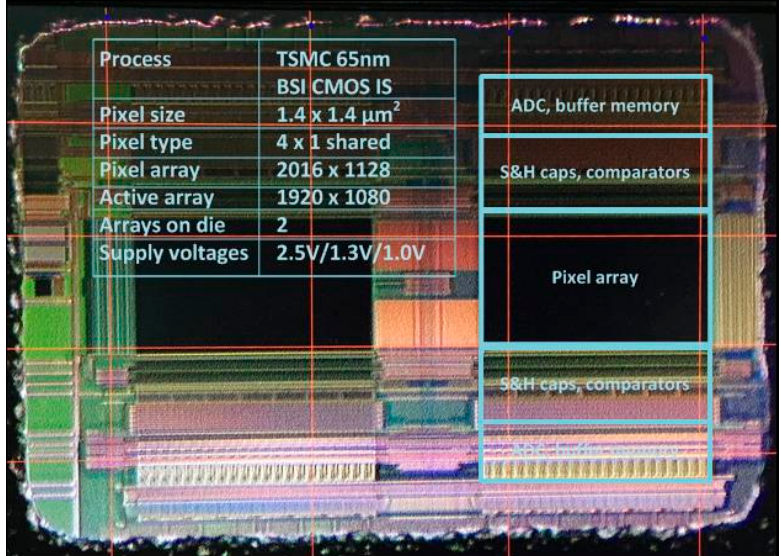
Figure 4. Sensor die photograph.